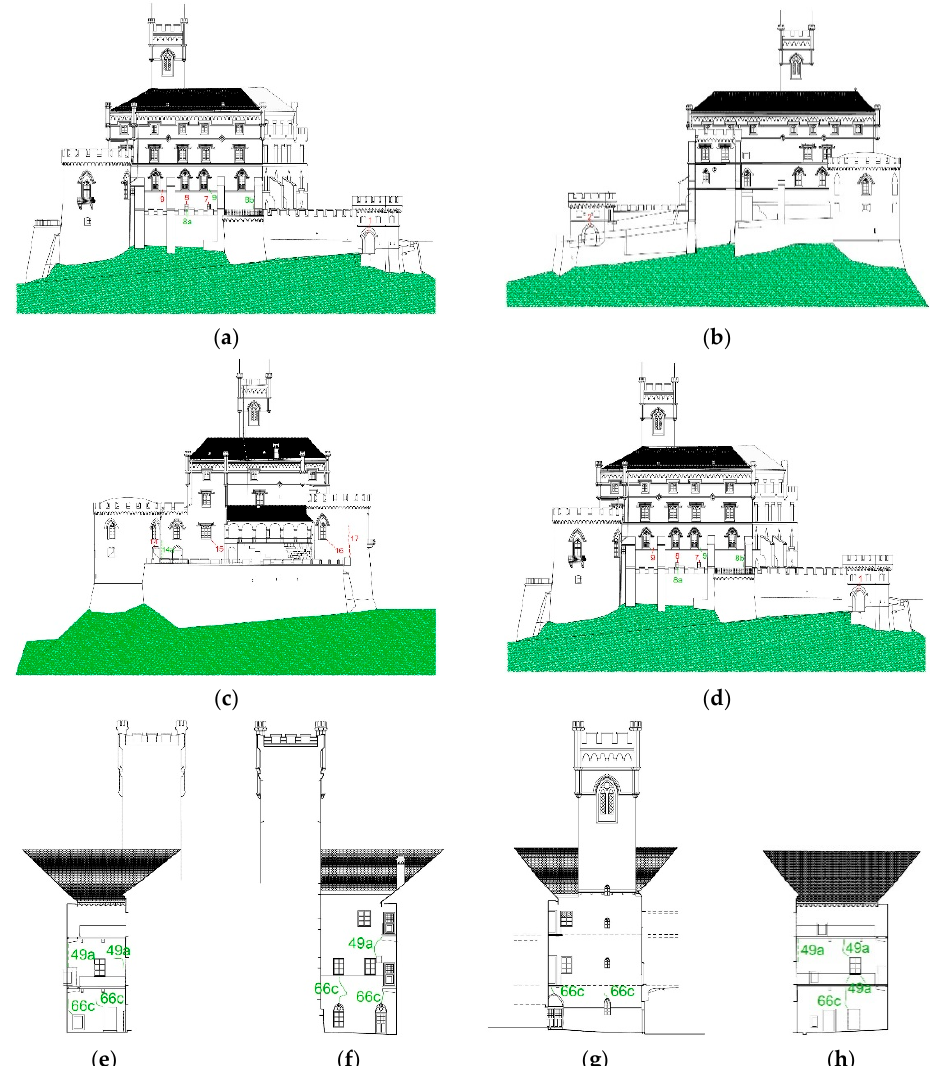
Figure 10. Map of crack positions observed during the in situ visual inspection: ( a ) Basement; ( b ) Ground floor; ( c ) First floor; ( d ) Second floor (note: red colored marks designate the damage after the Zagreb M5.5 2020 earthquake and green colored marks designate damage after the Petrinja M6.2 2020 earthquake).